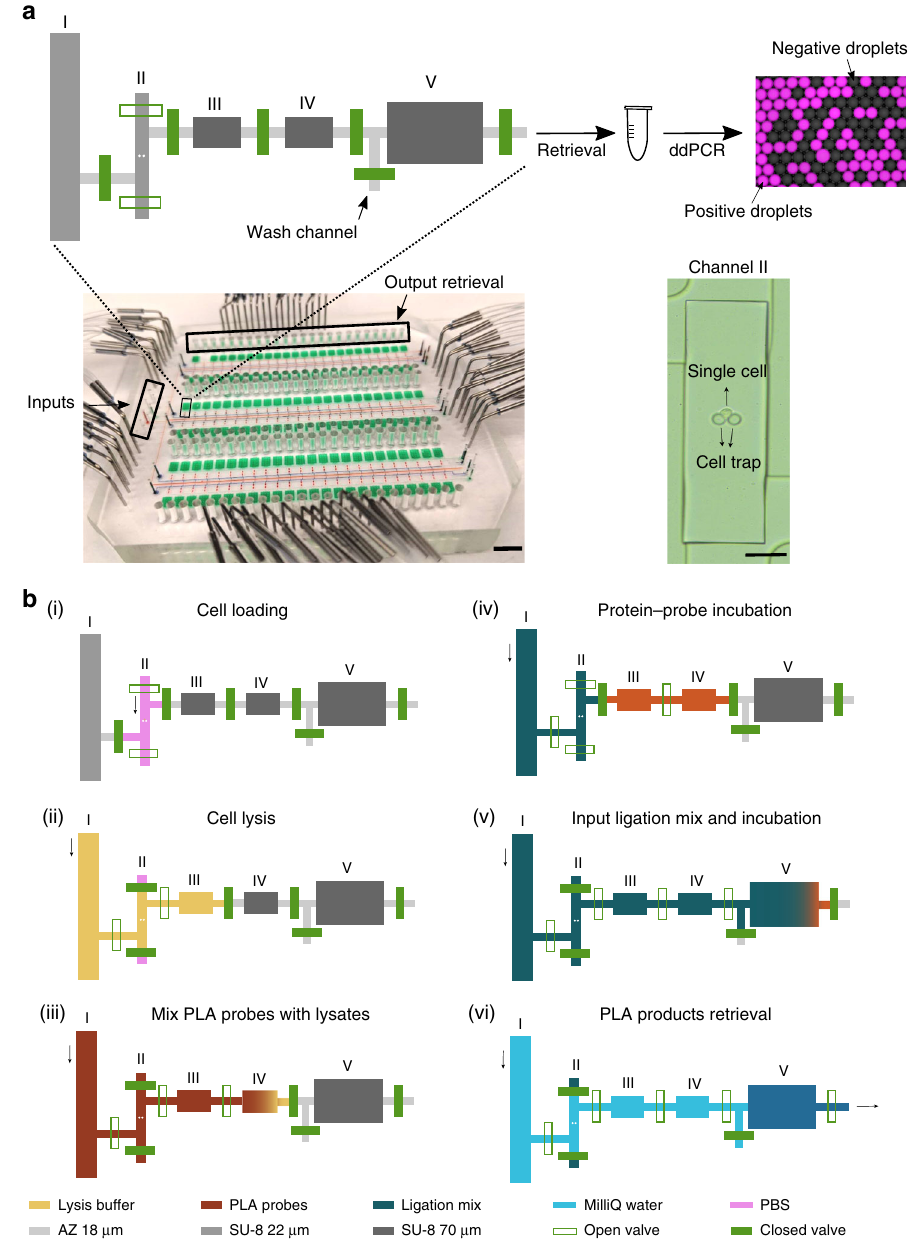
Fig. 1 Integrated micro fl uidic device for performing ultrasensitive single-cell protein/messenger RNA (mRNA) measurements. a , Top: The schematic of one unit of assay chambers is shown; chamber sizes are not to scale. The single cell is trapped in chamber II. The stepwise assay protocol (I – V) results in a digital PCR (dPCR) readout, where counting of positive droplets allows direct quantitation of proteins or mRNA in the sample. Bottom left: The chip image with food dye loaded in different channels, the scale bar is 2 cm. Bottom right: The microscope image of a single human embryonic kidney cell trapped